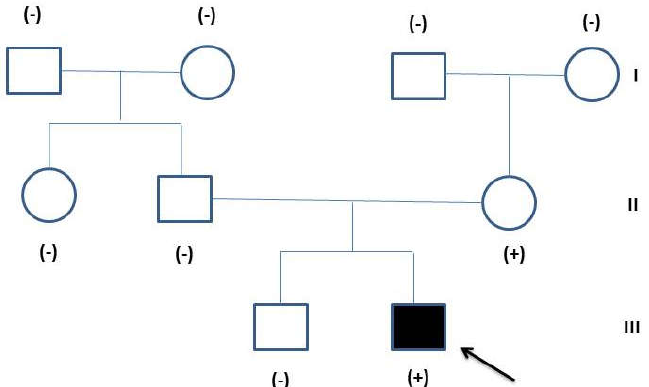
Fig. 2. Pedigreegram in this family: Schematic pedigree for our studied Family with an atypical heterozygous variant [c.1012G > C, p.G338R in exon 5 of TJP2 gene on chromosome 9 position 71836379 (GRch37)]. Circles indicate females; Squares indicate men; Filled symbols indicate affected individuals; Black arrow=proband; (+) =mutation identified; (-) =no mutation